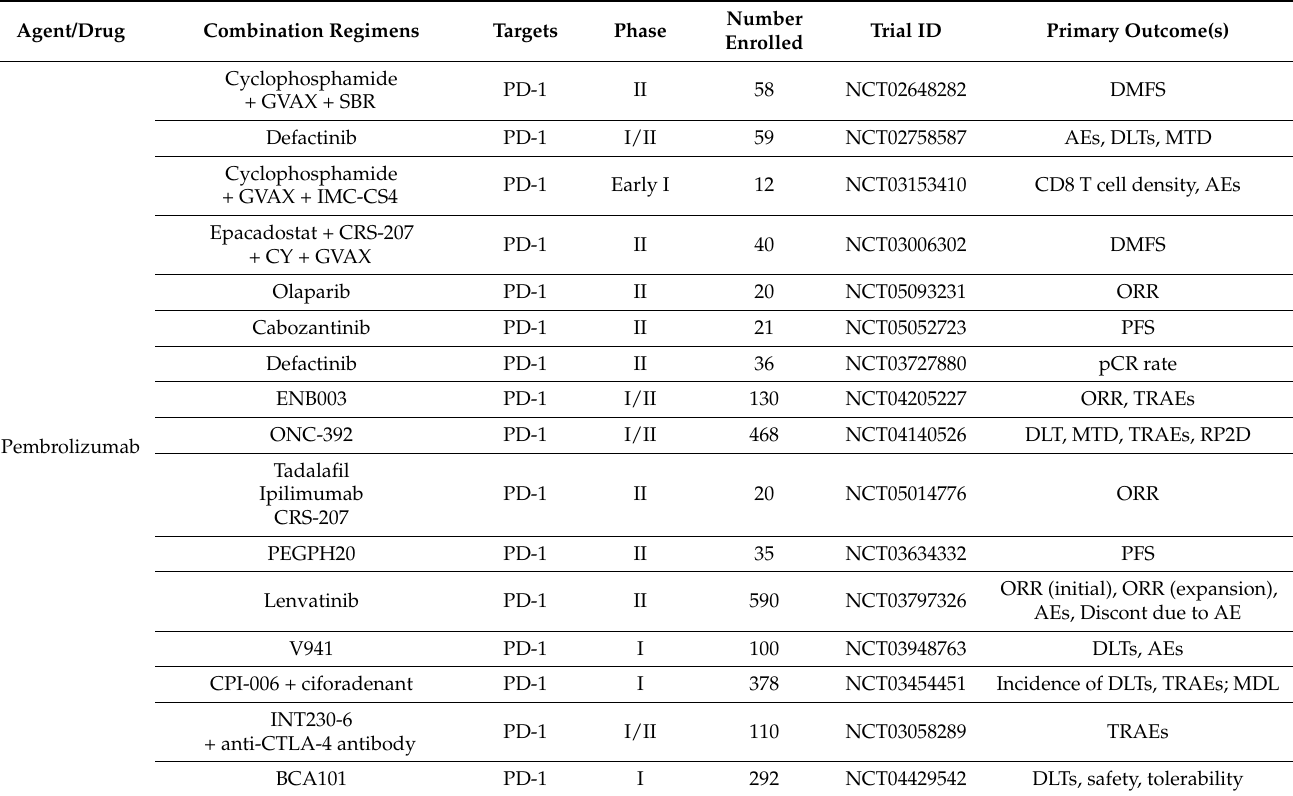
Table 1. Ongoing clinical trials targeting B7 family members in